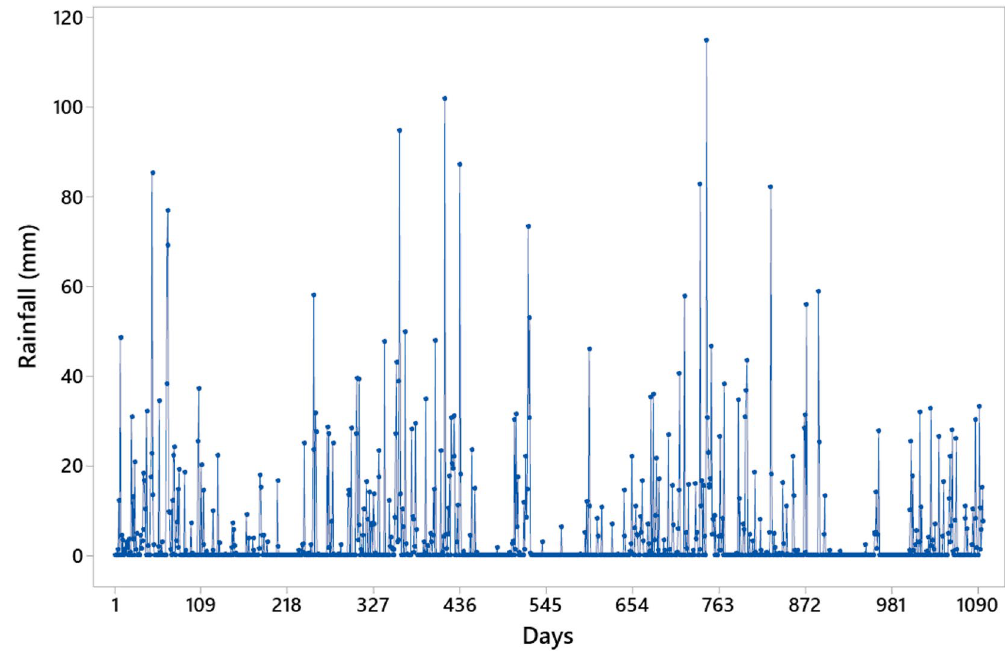
Figure 5. Original series with rainfall values in mm for the city of São Paulo, Brazil, from January 2015 to December 2017 (daily